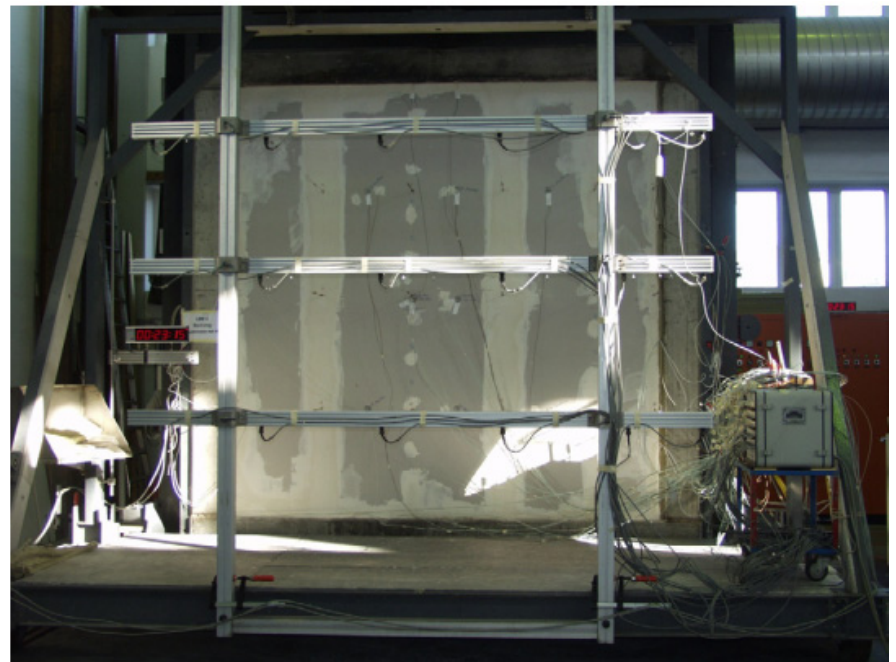
Figure 20. The full ‐ scale standard fire ‐ resistance ‐ test setup of the partition wall. Figure 20. The full-scale standard fire-resistance-test setup of the partition